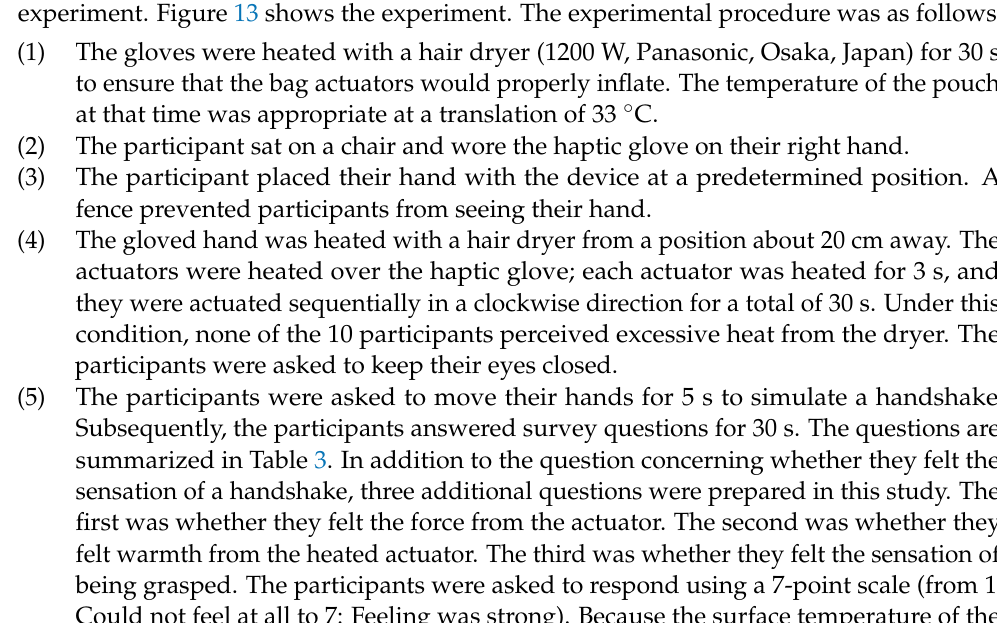
Table 2. The seven experimental patterns.